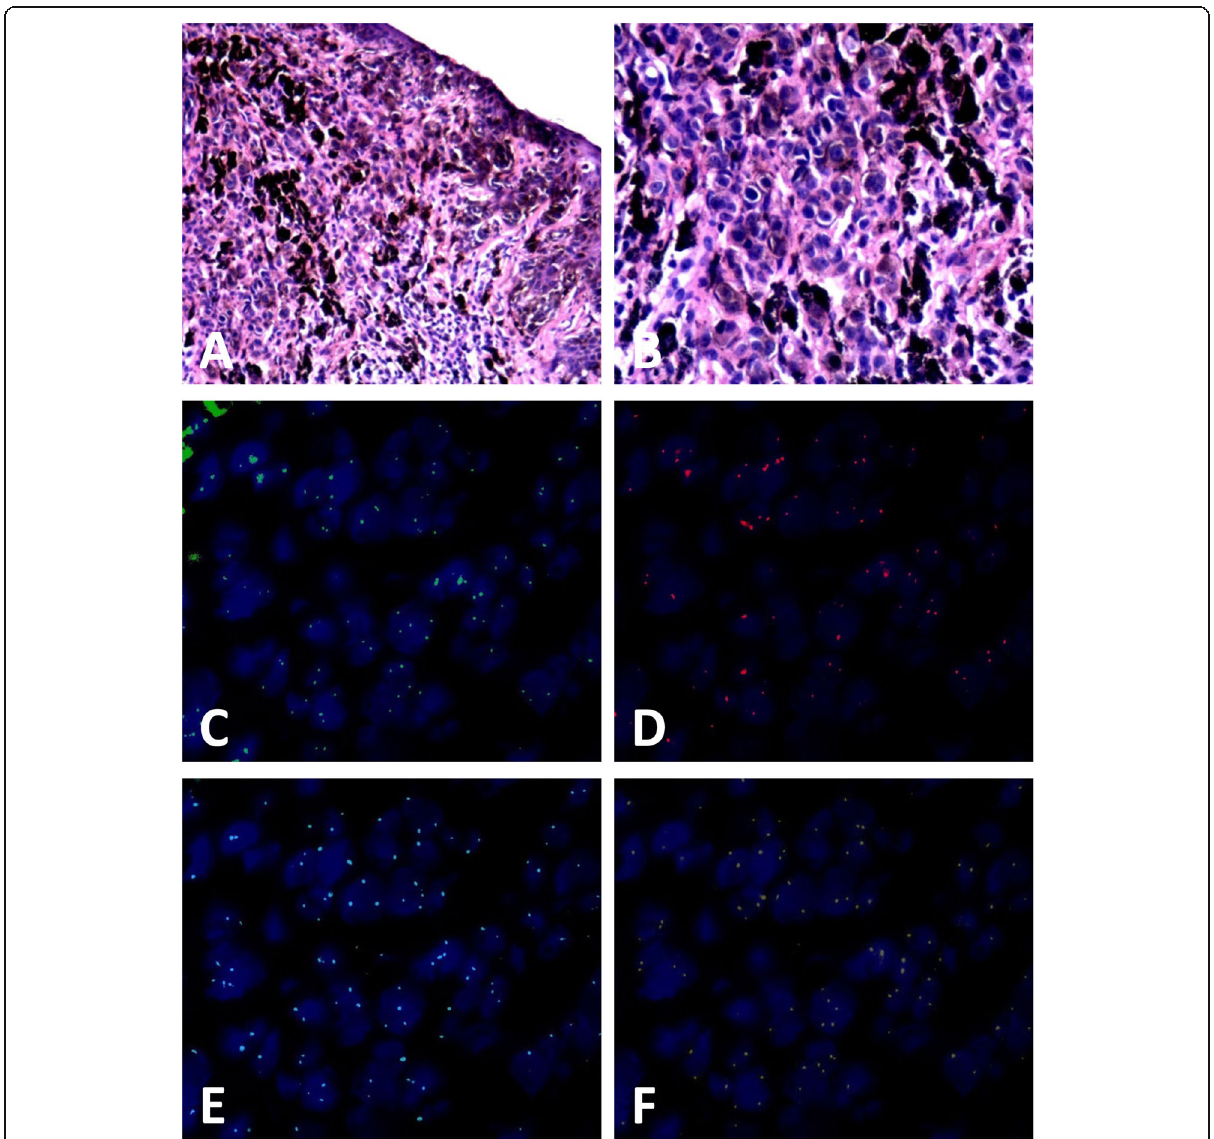
Fig. 4 Case of compound nevus positive by fluorescence in-situ hybridization (FISH) detection. a Melanocytes scattered in the basal layer of the epidermis and proliferated without maturation in the dermis (hematoxylin and eosin, H&E staining), ( b ) high-power magnification showed mild atypia of the melanocytes and no mitotic Fig. (H&E staining),( c-f ) FISH images showed the ( c ) gain of CCND1 (green signals), ( d ) gain of RREB1 (red signals),while the gain of RREB1 ( d , red signals) relative to CEP6 ( e , aqua signals) or loss of MYB ( f , gold signals) relative to CEP6 ( e , aqua signals) was not